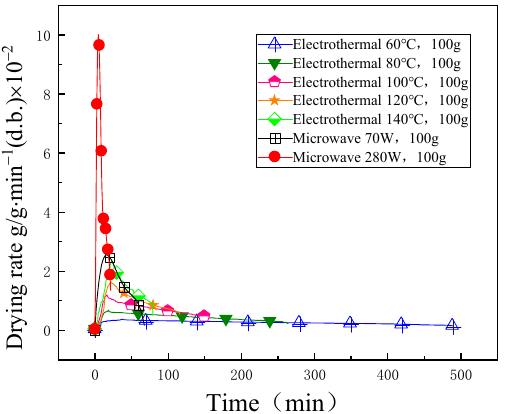
Figure 8. Comparison of moisture content curves between microwave drying and electrothermal drying.